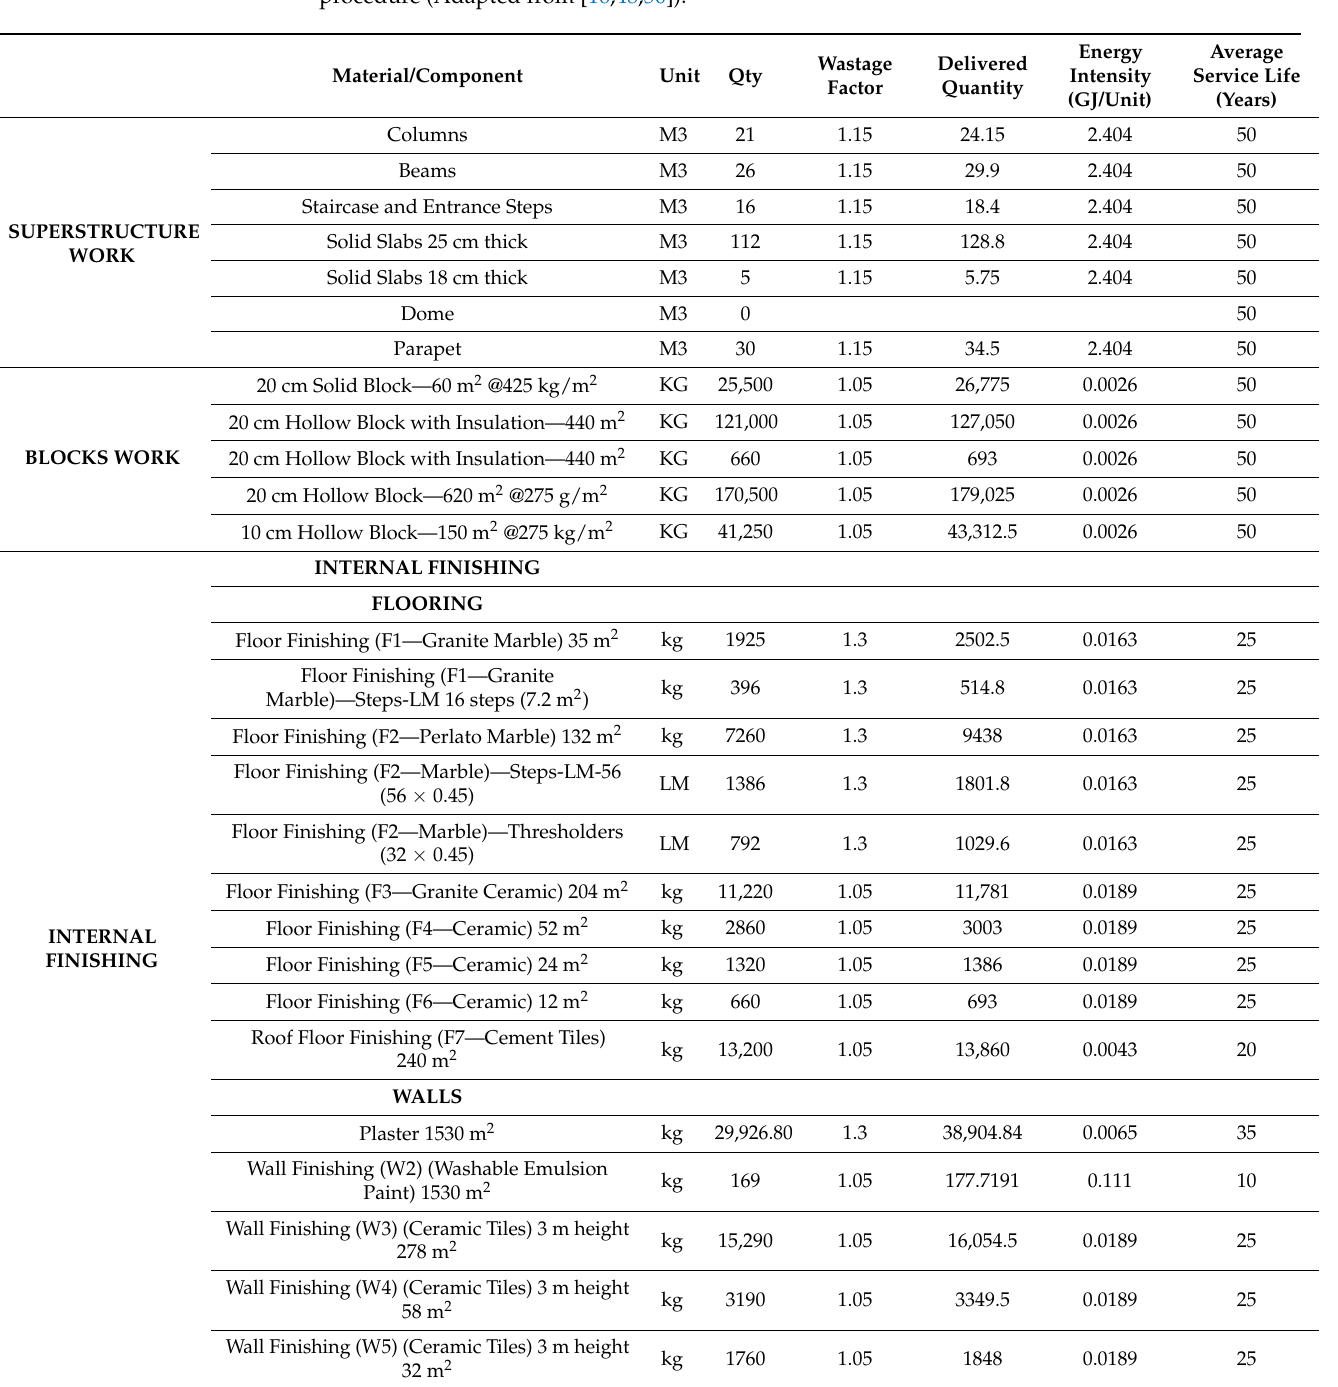
Table 2. Sample from Material schedule and EPIC database table used in the IOBHA assessment procedure (Adapted from